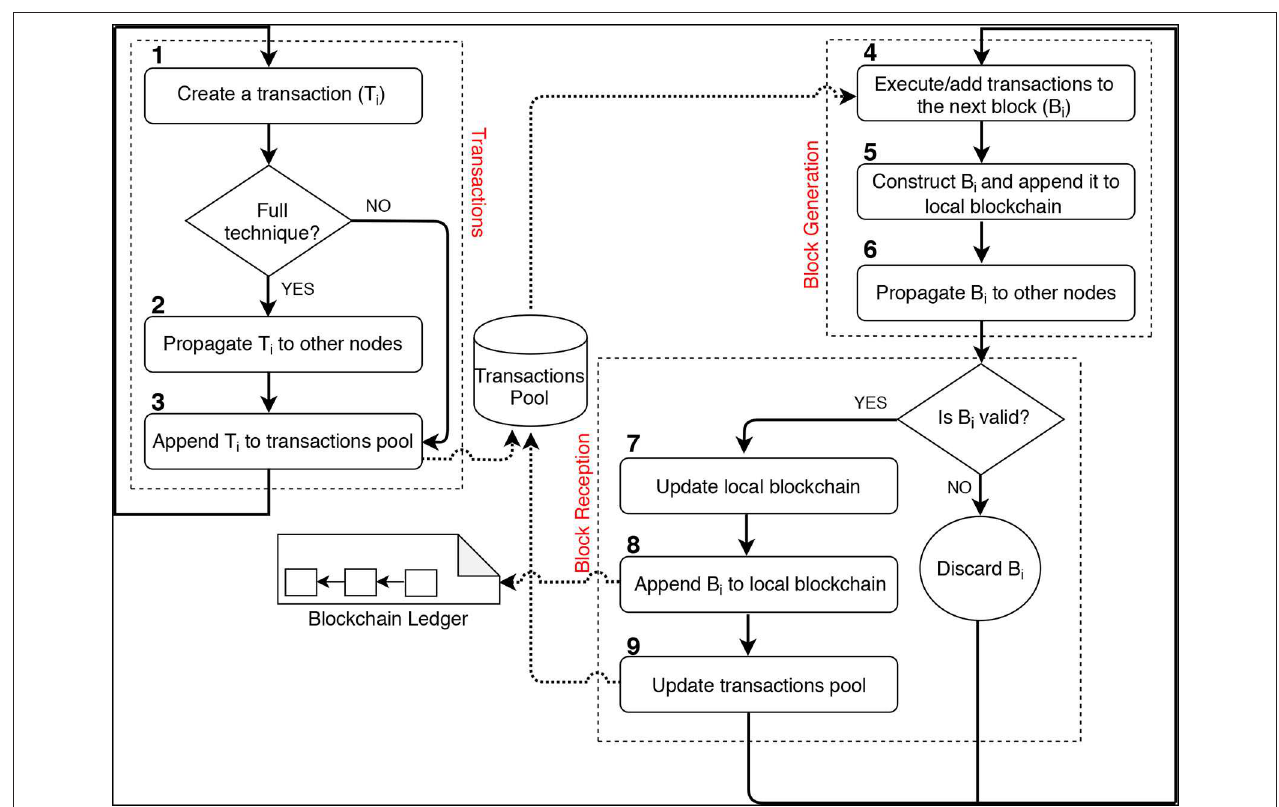
FIGURE 3 | Workflow for the consensus activities within the Base Model of